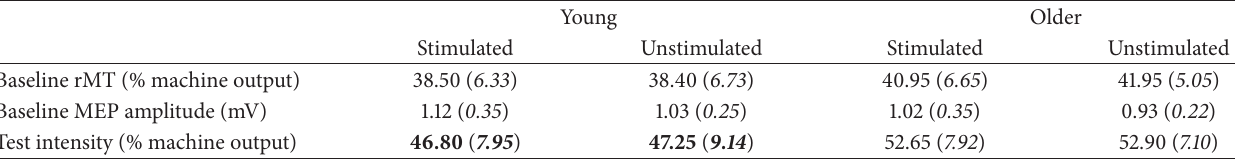
Table 1: Mean and standard deviations for baseline cortical excitability.